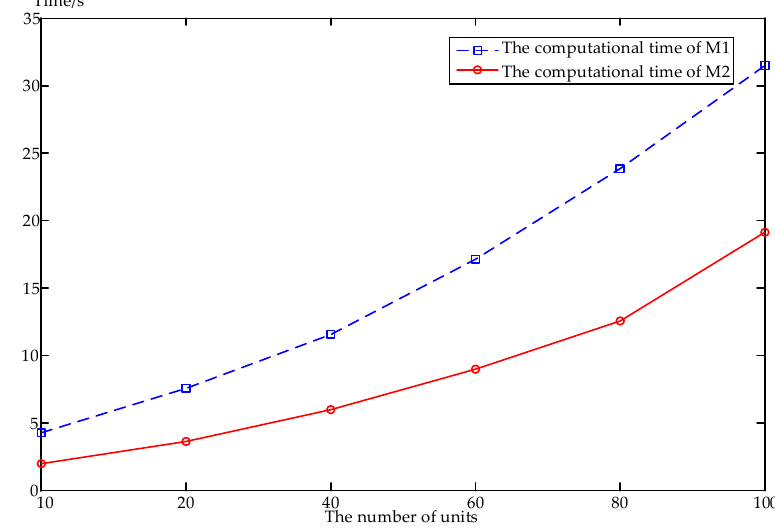
Figure 8. The comparison of the computational performance between M1 and M2.